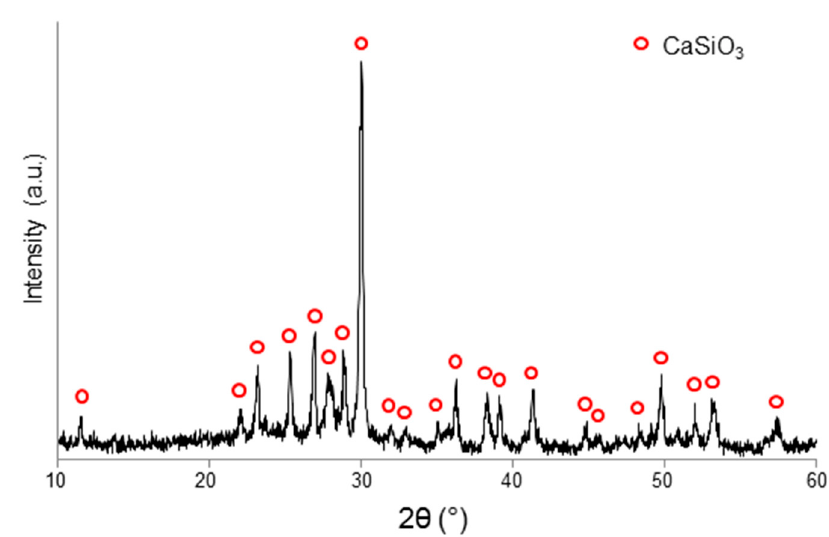
Figure 2. XRD pattern of a sintered coating (1000 °C/3 h).